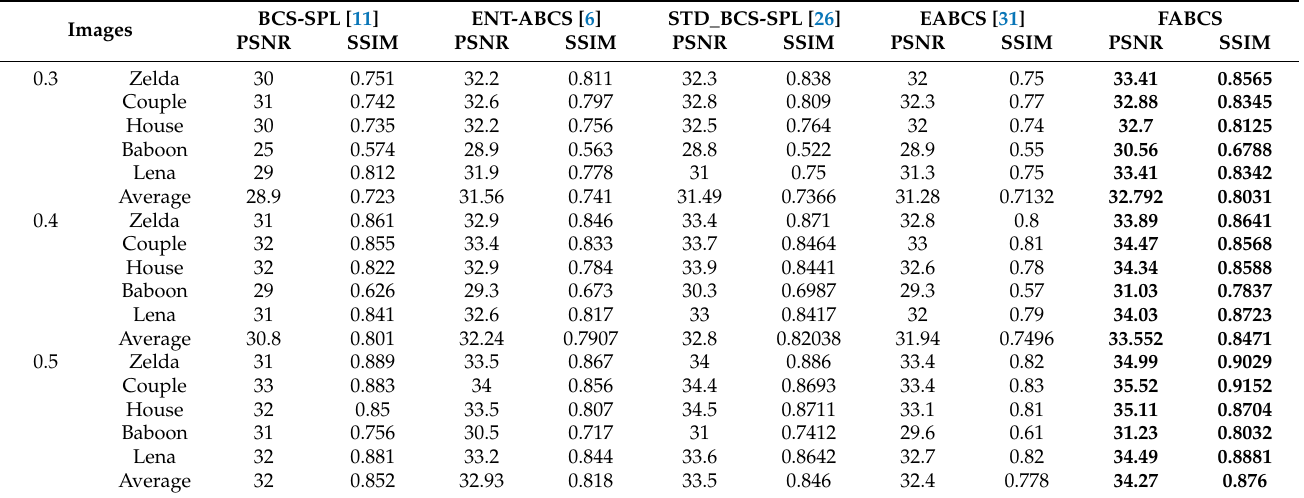
Table 2. Performance comparison of different state of the art methods based on PSNR and SSIM parameters for different state of the art methods at 0.3, 0.4, and 0.5